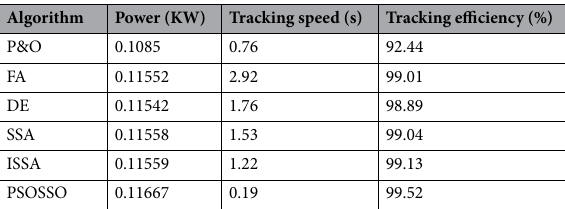
Table 3. Comparative analysis in terms of various parameters 37 .